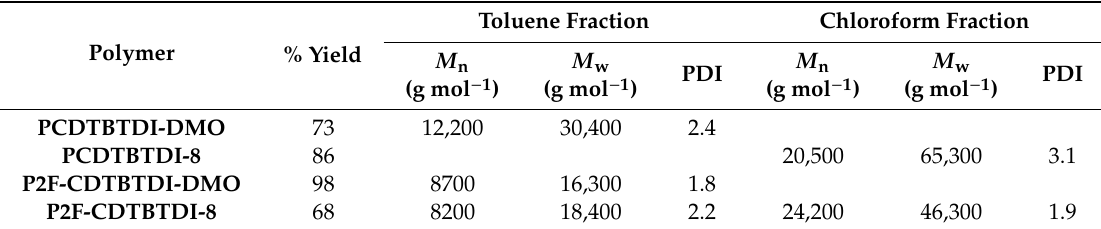
Table 1. The percentage yield, weight and number average molecular weights with